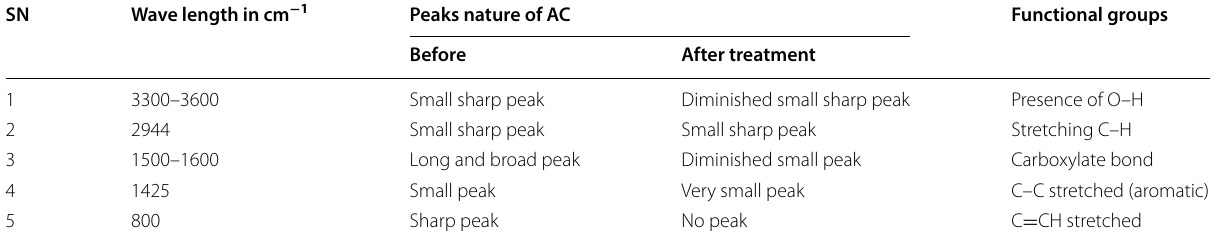
Table 3 FTIR analyses, AC peak observed and corresponding functional groups SN Wave length in cm − 1